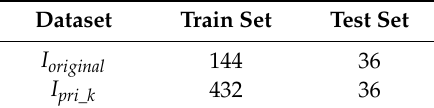
Table 1. The number of images in each set.